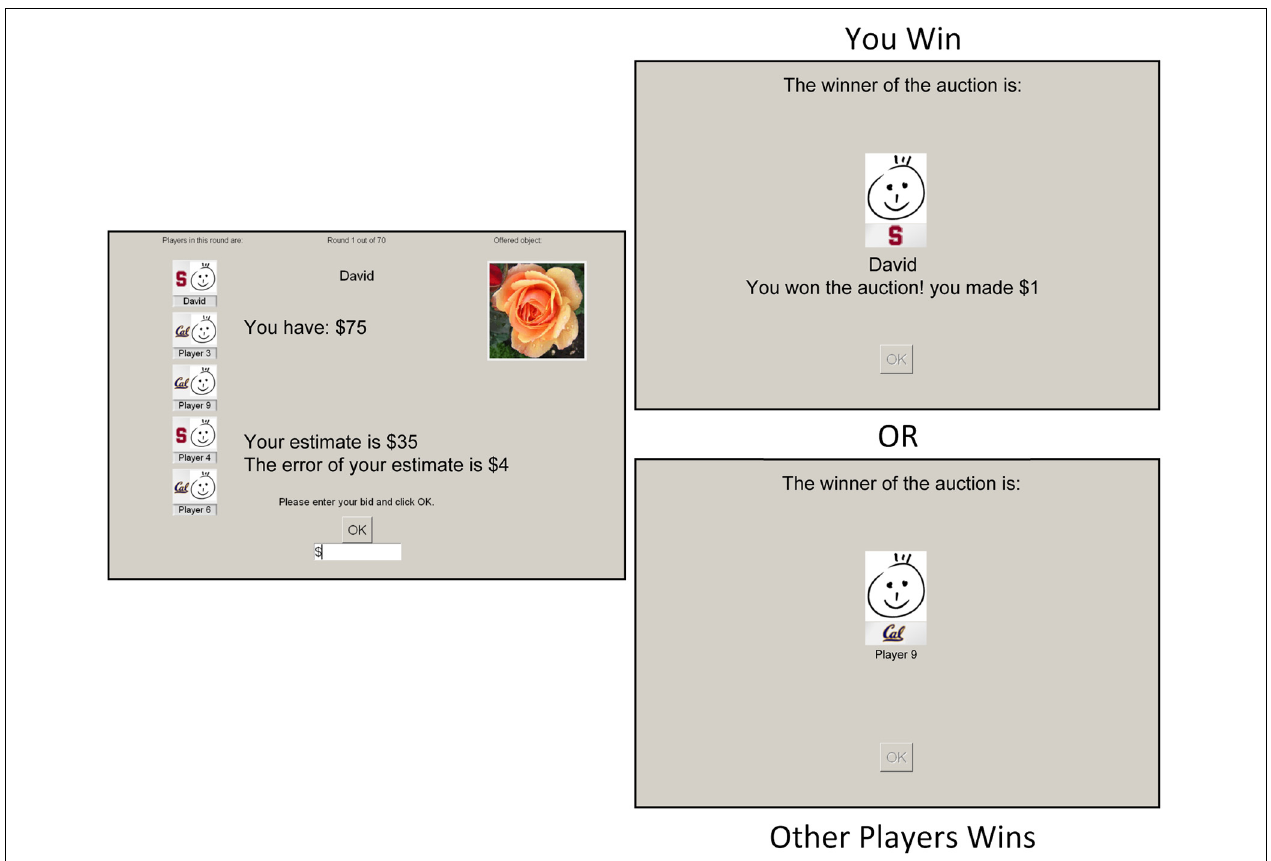
FIGURE 1 | Common value auction experiment design. Each round a new object (flower) was presented with an personal estimation of the value and error term indicating how much their estimation may differ from the real value. After all bids were submitted, the outcome was shown at a variable delay of